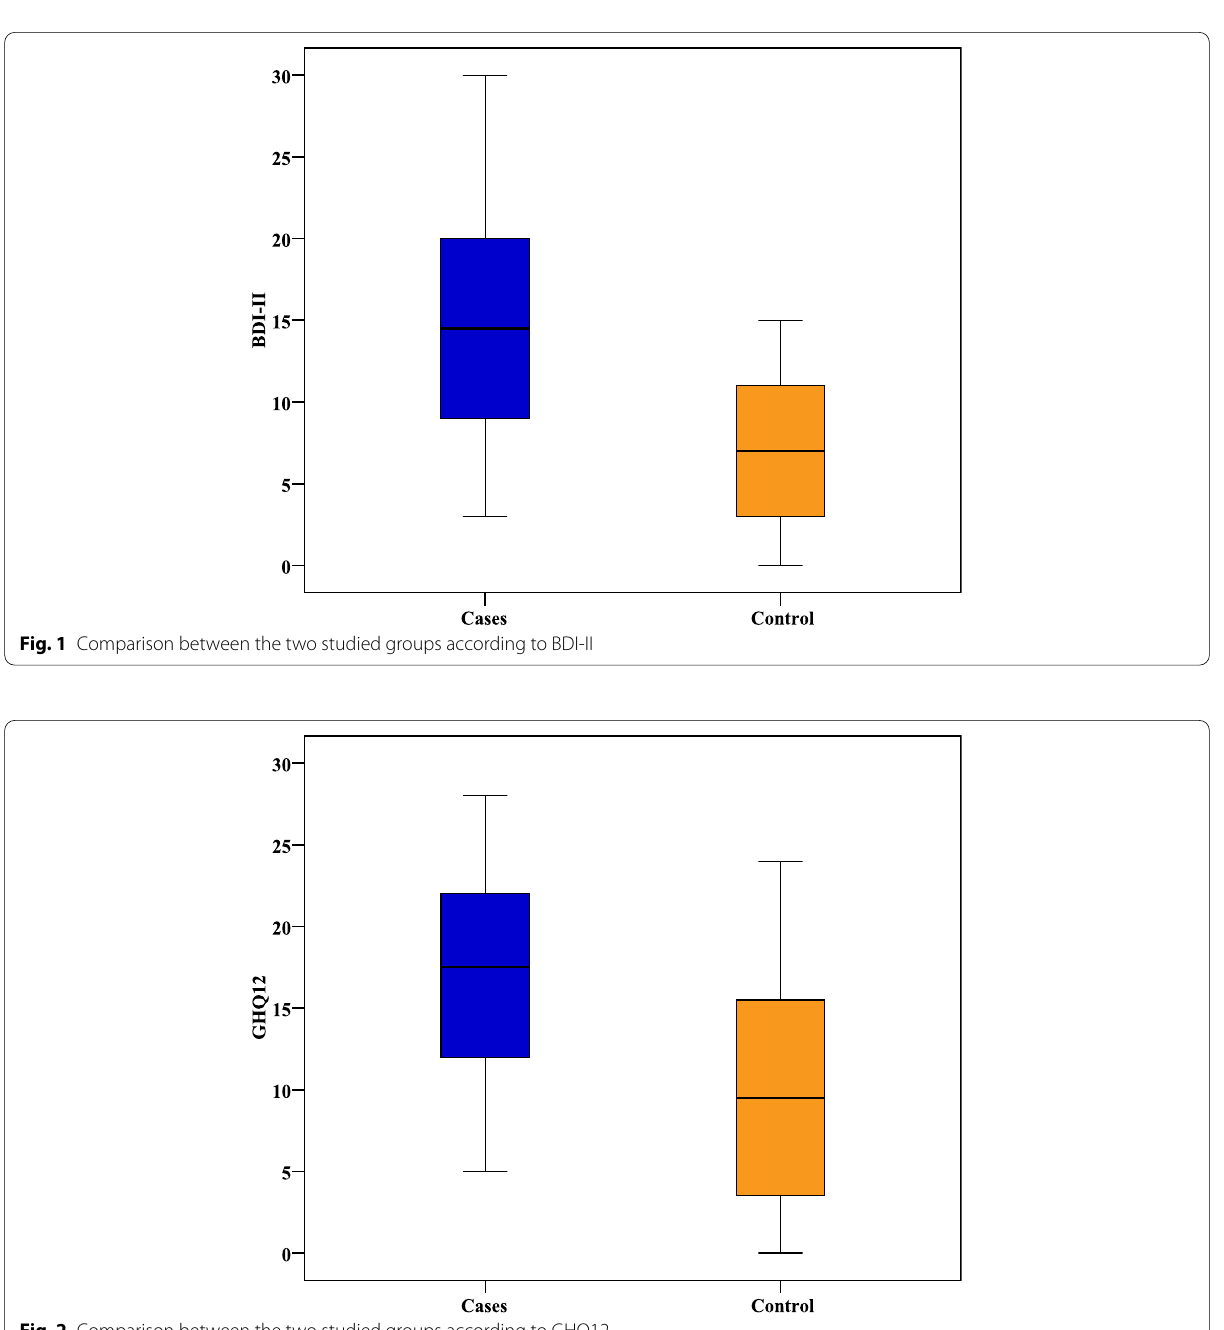
Fig. 2 Comparison between the two studied groups according to